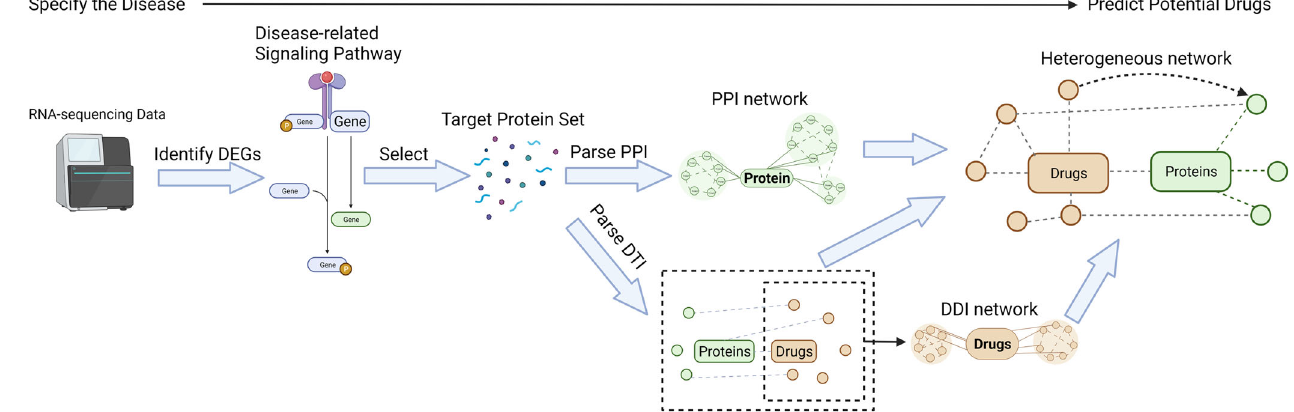
Fig. 4 Statistic analyses on gene expression Values from RNA-sequencing data identify DEGs. The signaling pathways that contain the highest ratio of DEGs are regarded as disease-related. All or part of proteins in these pathways are selected to form the target protein set. By parsing PPI and DTI data from databases, the PPI network and the DTI network are constructed. The drug molecules in the DTI network are also used to parse and construct the DDI network. Finally, the DDI and the PPI are connected by the DTI, and thus the heterogeneous network is constructed. The task of predicting the potential drugs for a given disease is now transferred to the prediction of the interactions between the proteins and the drug molecules. Abbreviation: DEGs Differentially Expressed Genes, PPI Protein-Protein Interaction, DDI Drug-Drug Interaction, DTI Drug-Target